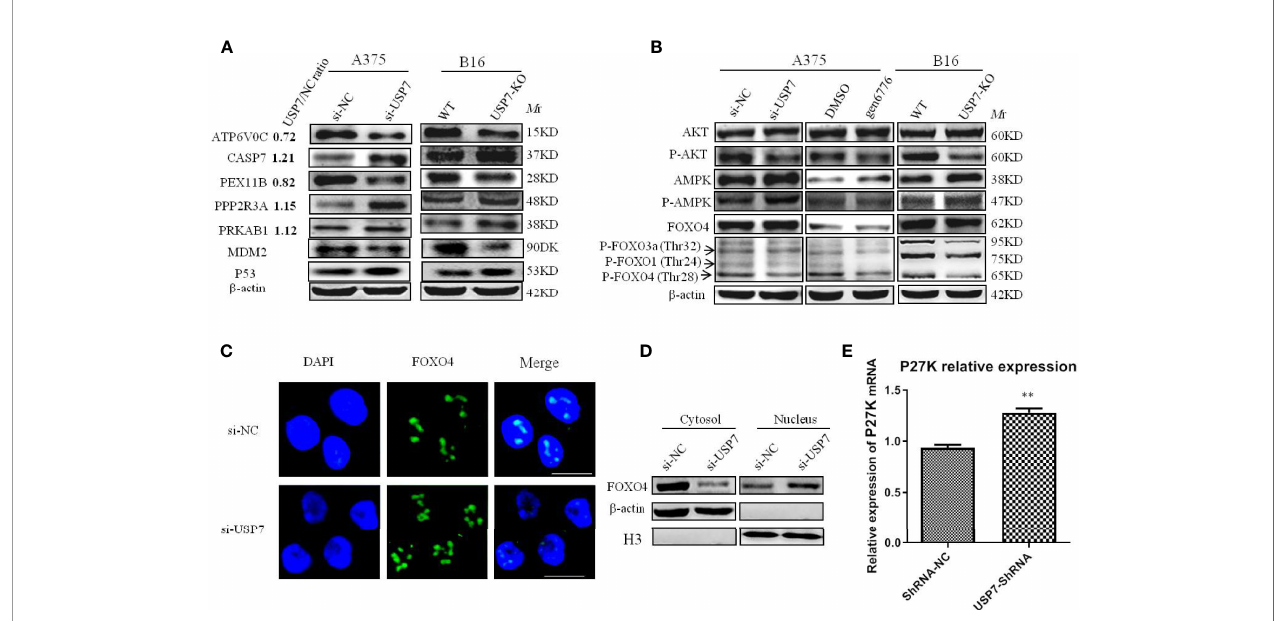
FIGURE 4 | Multiple proteins and PI3K/AKT/FOXO and AMPK signaling pathways are affected by removal of USP7. USP7 was inhibited by siRNA or inhibitor gen 6776 in A375 cells and was knocked out through CRISPR/Cas9 in B16 cells. (A) Proteins exhibiting signi fi cant changes between USP7 knockdown A375 cells and A375 cells and USP7-KO B16 cells. Protein names, USP7/NC ratio, and the expression of indicated proteins by western blotting are shown. (B) The key proteins levels of the PI3K/Akt/FOXO and AMPK signaling pathways were analyzed by western blotting after inactivation of USP7 in A375 cells and B16 cells. (C, D) The expression of FOXO4 in the nucleus and cytosol was detected by immuno fl uorescence and western blotting, respectively. Green, FOXO4; blue, nucleus. Scale bar 50 m m. (E) Representative levels of P27 kip1 by quantitative real-time PCR. Data are represented as the mean ± SEM of three independent experiments, each in triplicate; bars, SEM. **P ≤ 0.01 vs.